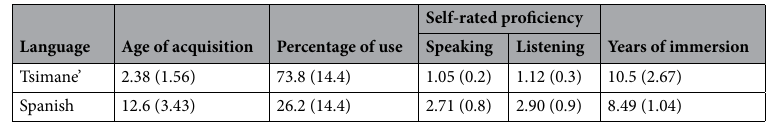
Table 6. Linguistic profile of the bilingual population. Participants were asked to rate their proficiency from 1 (excellent) to 5 (beginner). Years of immersion refers to the amount of time the speaker has lived in a community where the dominant language is either Tsimane’ or Spanish. SD in